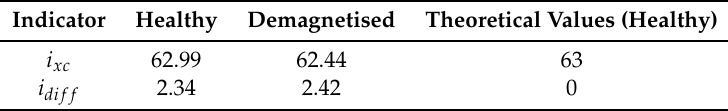
Table 4. Indicators computed from simulation data—12,500